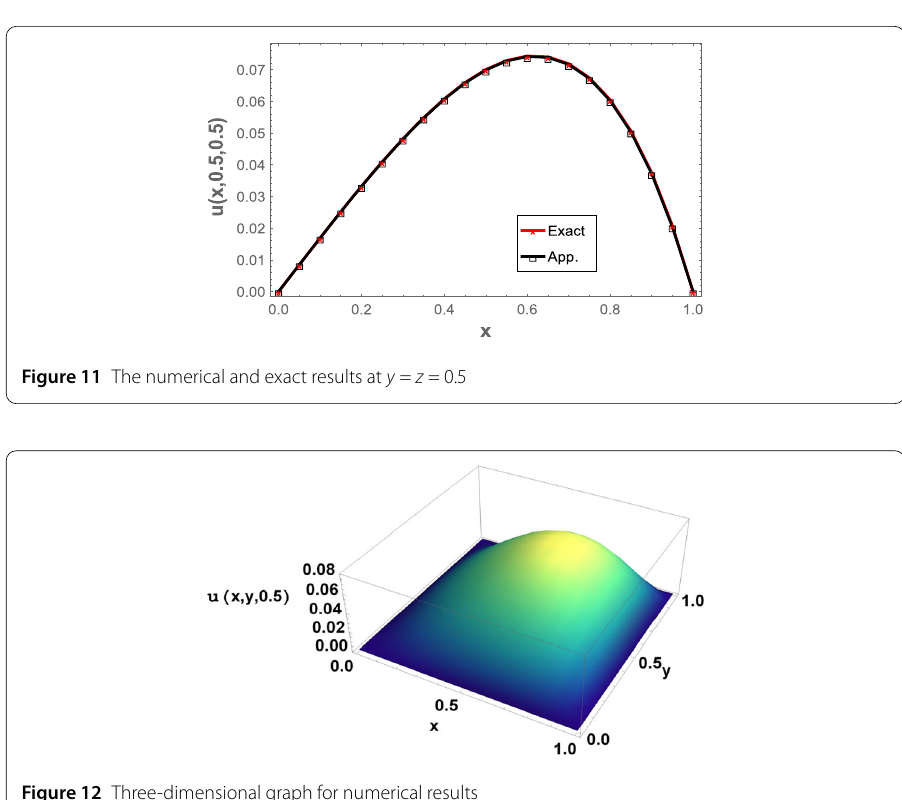
Figure 12 Three-dimensional graph for numerical results